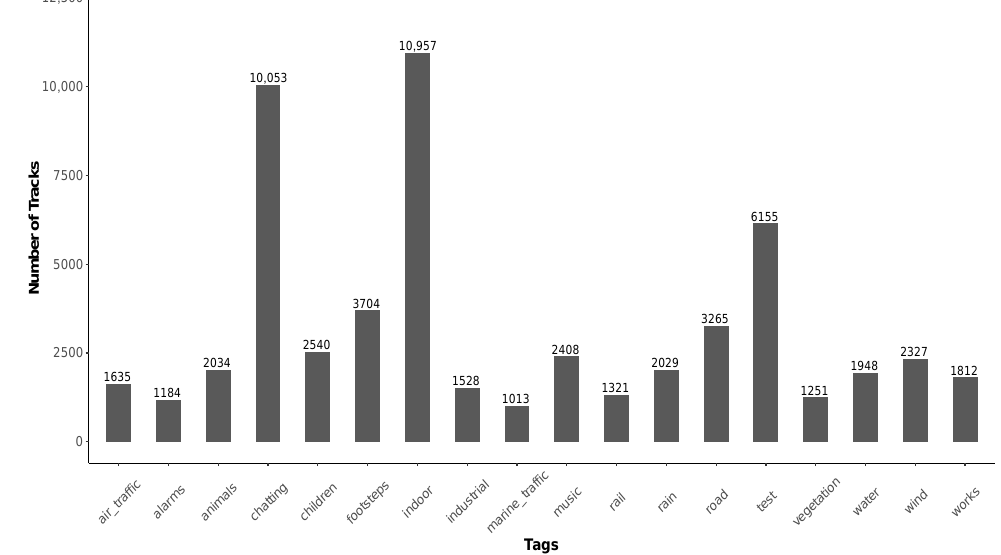
Figure 7. Distribution of the tags used for tracks collected by user who have 1 only contribution to the database. Table 8. Distribution of the time length (in second) in function of the number of track measurements for tracks collected by user who had 1 contribution to the database. Time Length